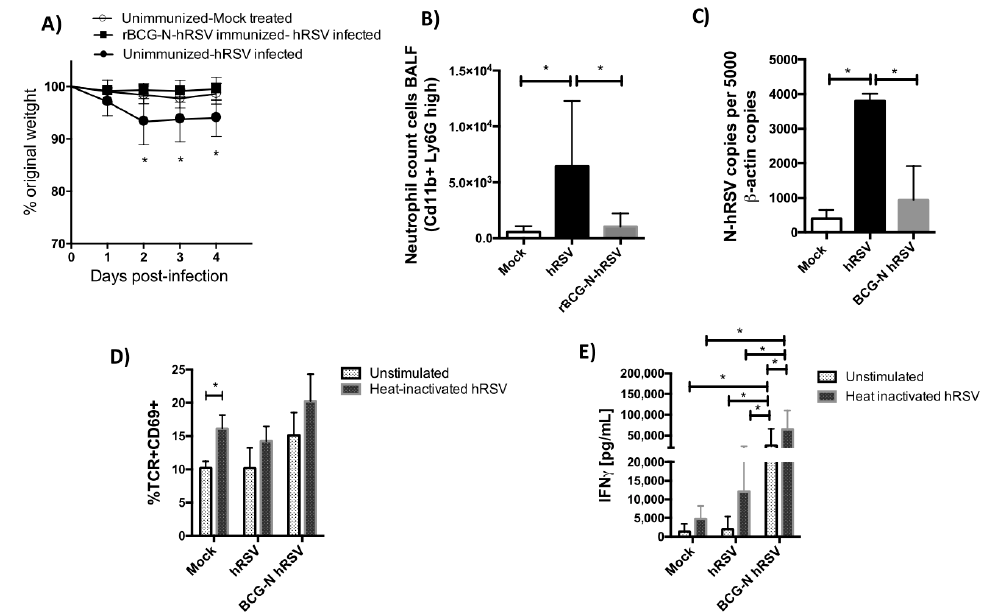
Figure 3. T cell expansion induced by hRSV infection in rBCG-N-hRSV vaccinated mice. BALB/cJ mice were immunized with BCG-N, and 14 days postimmunization were infected with 1 × 10 6 PFU of hRSV. Four days after infection, mice were euthanized. Bodyweight was measured for four days ( A ). Also, neutrophils count ( B ) in the BALF was evaluated using FACS. ( C ) Viral loads were evaluated by RT-qPCR. ( D ) The spleens of mice sacrificed at seventh day postinfection were collected, and the resulting splenocytes were then stimulated with heat-inactivated hRSV (HI-hRSV) (57 °C for 30 min). Seventy-two hours poststimulation, TCR + CD69 + cells as a T cell activation marker were detected by flow cytometry (d) and IFN- γ production was detected by ELISA ( E ). ( A ) Two-way ANOVA paired test and multiple t - students test were performed to assess statistical differences (* p < 0.05) indicating statistical difference in (i) time and infection/treatment condition, (ii) significant decrease of percent original weight in hRSV- infected as compared to mock-treated and to rBCG-N-hRSV-inmunized hRSV-infected mice at days 2, 3 and 4 postinfection. ( B – E ) t -students tests were performed (* p < 0.05). Bars represent mean ± SD in all graphs.